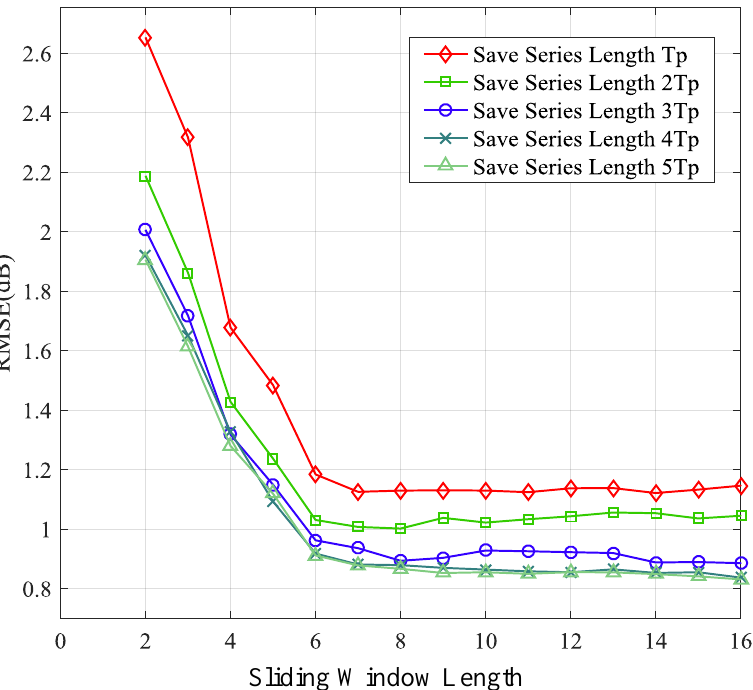
Figure 14. Root mean square error (RMSE) of 1-step ahead prediction with different length of sliding window and stored series.